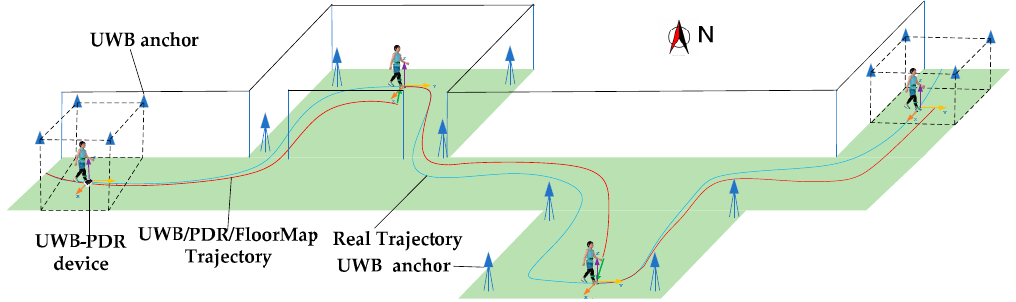
Figure 1. System concept of the proposed pedestrian navigation system based on UWB / PDR / Floor Map.